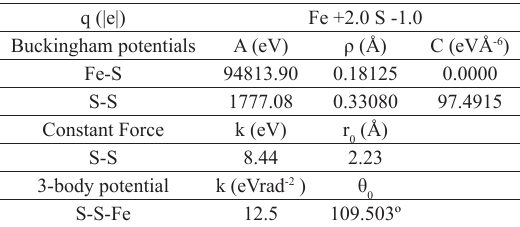
Table 1. Interatomic potentials for FeS